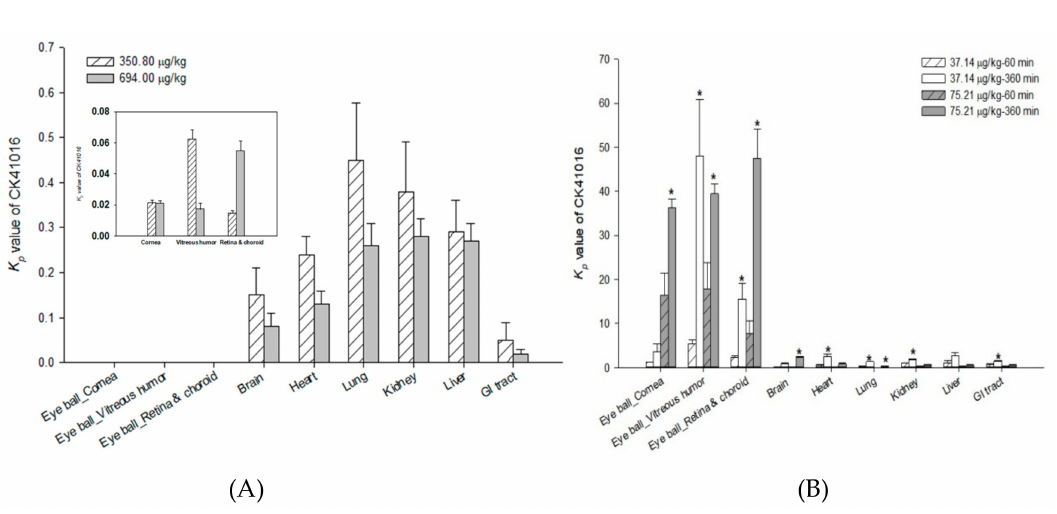
Figure 5. Mean tissue-to-plasma partition coe ffi cient (Kp) values of CK41016 in rat tissues after IV (at 720 min) ( A ) or eye drop (60 and 360 min) administration ( B ) (mean ± SE, n = 5, * p < 0.05 between 60 and 360